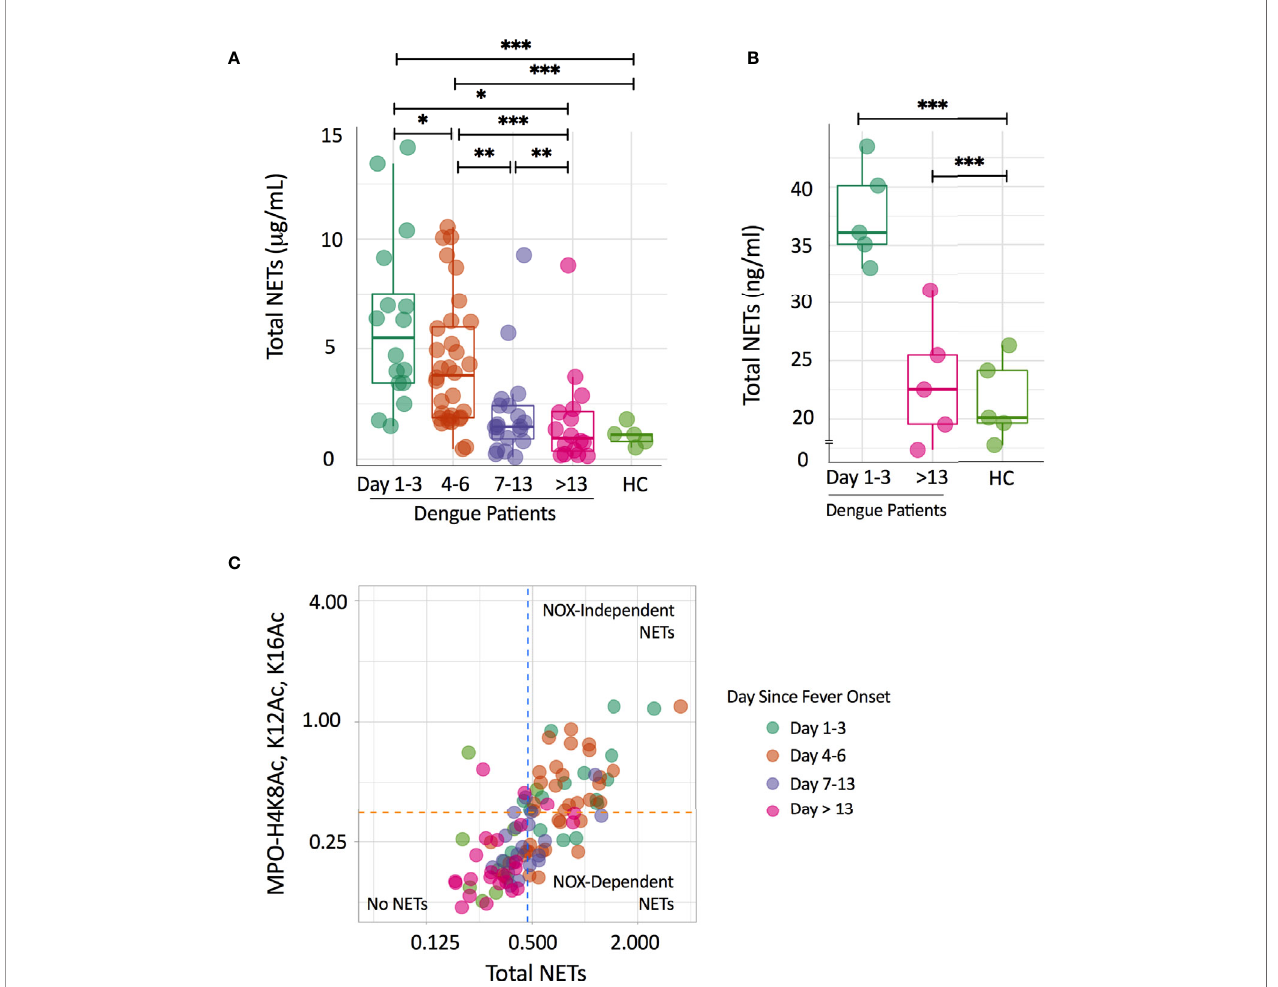
FIGURE 1 | Circulating NETs in dengue patients are mainly NOX-independently generated. (A) Time course of total NETs ( m g/mL) in plasma of dengue patients according to day since fever onset and in a group of healthy controls (HC). Depicted are individual data together with a box plot showing median with interquartile range. Differences in the dengue patients over time were analyzed using the Wilcoxon signed rank test; differences with the HC group were analyzed using Mann- Whitney U test; * p < 0.05, **p < 0.01, ***p < 0.001 . (B) NET formation (ng/ml) after incubation of neutrophils with 10% plasma of dengue patients according to day since fever onset and of a group of HC. Depicted are individual data of fi ve plasmas per group tested on 3 neutrophil donors, together with a box plot showing median with interquartile range. Differences with the HC group were analyzed using Mann-Whitney U test; , ***p < 0.001 . (C) Scatterplot quadrant analysis to differentiate NOX-dependent and NOX-independent NET formation on the basis of results of the total NETs (X-axis) and MPO-H4K8Ac, K12Ac, K16Ac assay (Y-axis). Cut-off points were determined from mean values and standard deviations from HC samples (orange and blue-dotted lines). Samples positive to both assays were classi fi ed as NETs derived NOX-independently, while samples only positive for MPO-DNA were classi fi ed as NETs derived from NOX-dependently. HC, healthy controls; NOX,